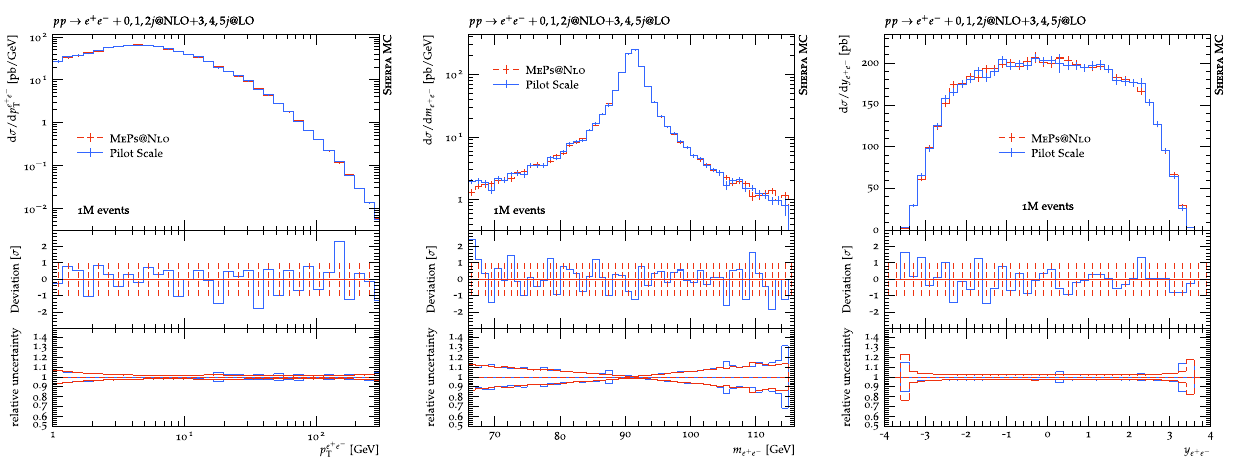
Fig. 6 Predictions for the Born-level observables m e + e − and y e + e − , and for the dilepton transverse momentum in comparison between the M E P S @N LO algorithm (red dashed) or the pilot scale strategy (blue solid) described in Sect. 4